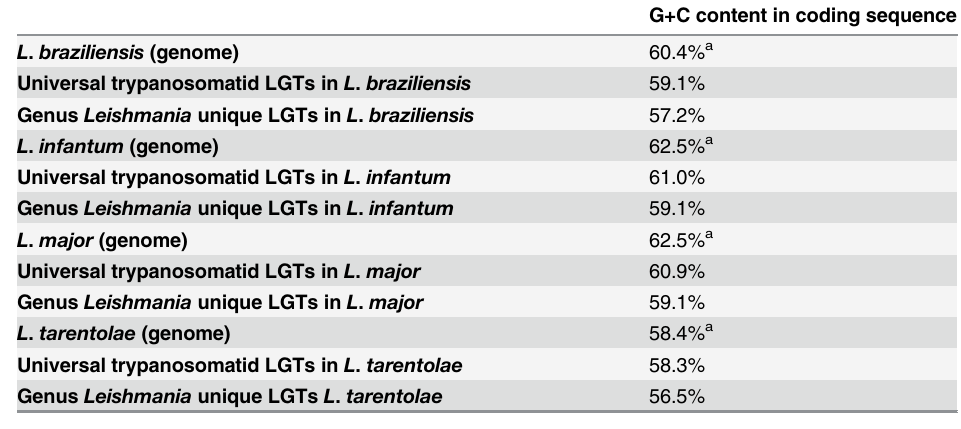
Table 3. G+C content of coding content of complete genomes and in sets of